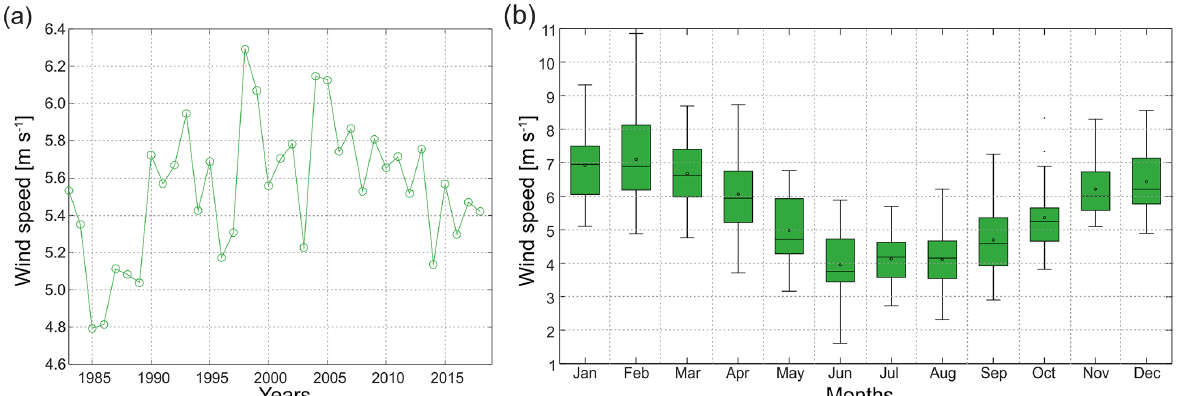
Figure 7. (a) Variability of mean annual wind speed in 1983–2018 at Hornsund. (b) Variability of the mean monthly wind speed at Hornsund in the period 1983–2018.